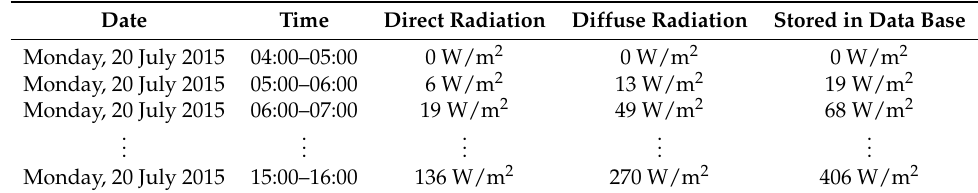
Table A2. Excerpt Weather Data